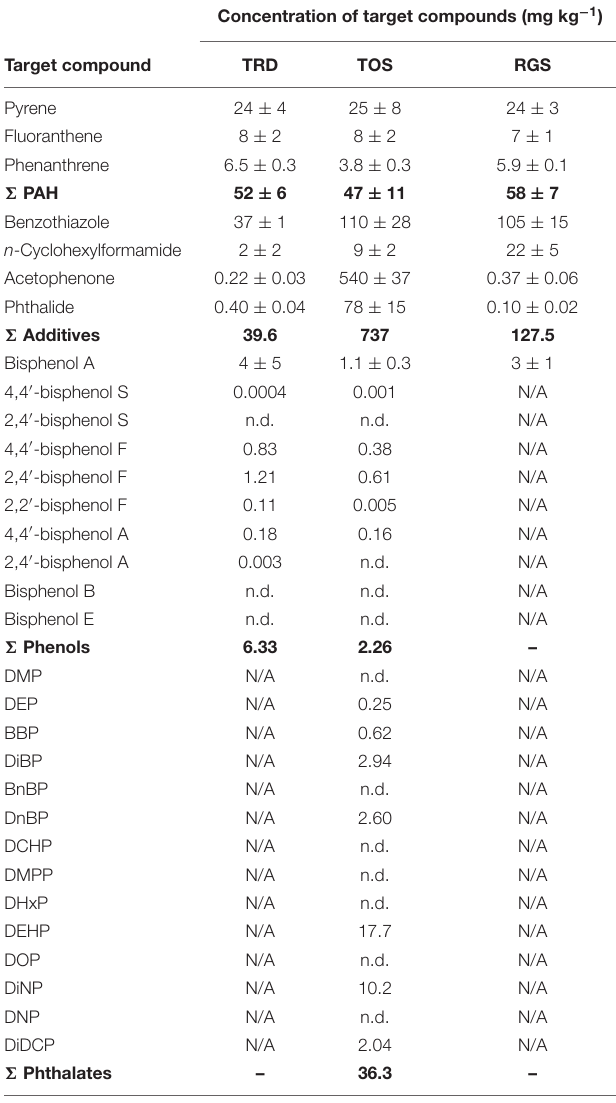
Data is presented for field collected CRG from a football field (TRD), pre-use CRG (TOS), and ‘pristine’ CRG (RGS). Standard deviation is given where replicates were measured (n = 3). n.d. = not detected. N/A = not